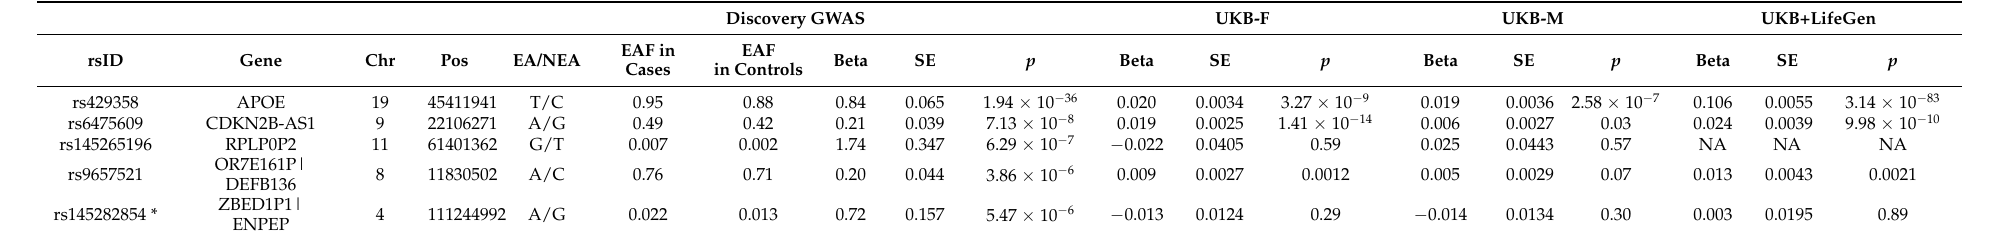
Table 1. Summary of Lead SNPs in Significant